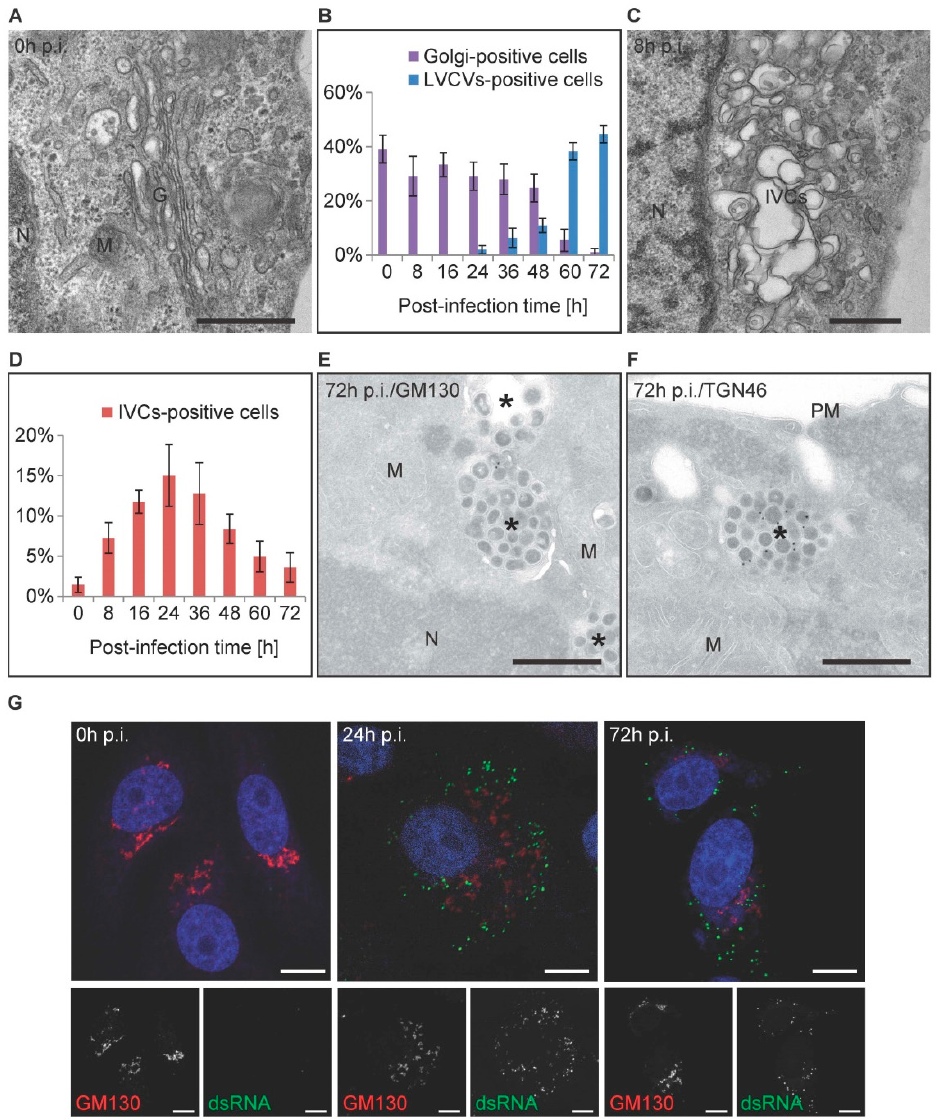
Figure 4. The Golgi complex undergoes reorganization over the course of a PEDV infection. Vero E6 cells infected with PEDV were collected at different p.i. timepoints, as described in the Materials and Methods section, before being processed for conventional EM ( A – D ), immuno-EM ( E , F ), and immunofluorescence ( G ). ( A ) A Golgi complex observed at 0 h p.i., which is typically composed of few long tubular stacks, with vesicles in their proximity; ( B ) the percentage of cell sections in the experiment shown in Figure 1 that displays a Golgi complex and/or an LVCV; ( C ) typical morphology of an irregular vesicle cluster (IVCs), which is a closely packed, irregular shaped, single-membrane vesicle with a light content; ( D ) the percentage of cell sections in the experiment shown in Figure 1 which are positive for IVCs. (E, F) PEDV induces the formation of LVCVs, which are positive for the Golgi stack and trans-Golgi protein markers GM130 ( E ) and TGN46 ( F ), respectively. Asterisks mark the LVCVs; ( G ) the subcellular distribution of GM130 (red) was examined by immunofluorescence over the course of a PEDV infection (green), at 0, 24, 48 and 72 h p.i. The anti-dsRNA staining was employed to identify infected cells and nuclei were stained with DAPI dye (blue). Representative immunofluorescence images were from three independent experiments. Error bars represent the standard deviation from three grids. G: Golgi; M: mitochondrion; N: nucleus; PM: plasma membrane. Black scale bar: 500 nm; white scale bar: 10 μ m.